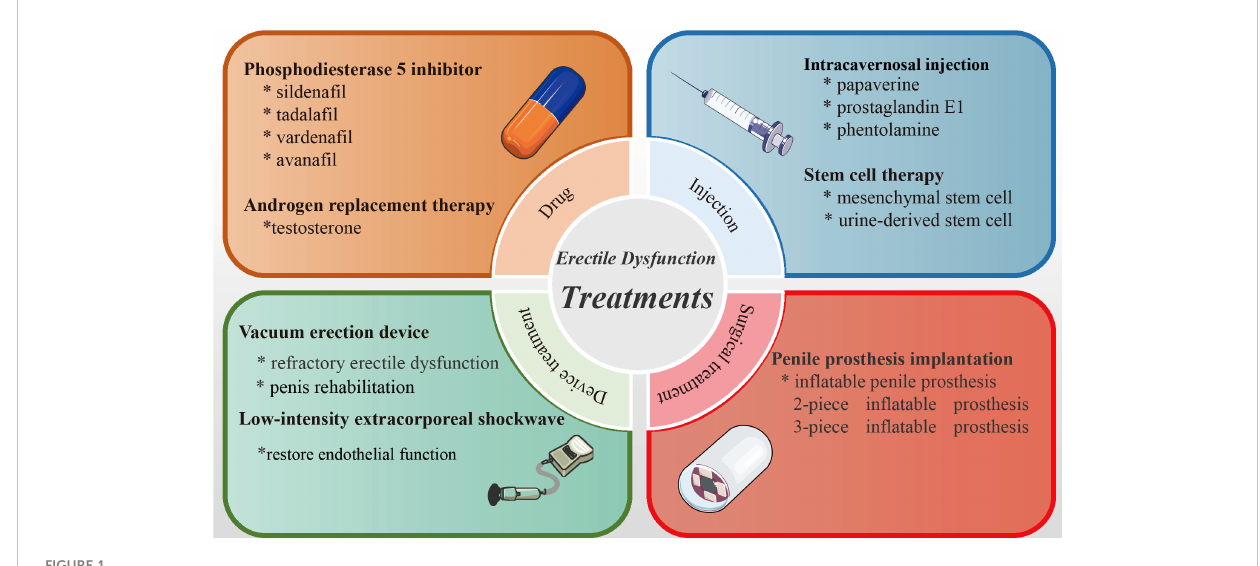
FIGURE 1 Summary diagram of the therapies of erectile